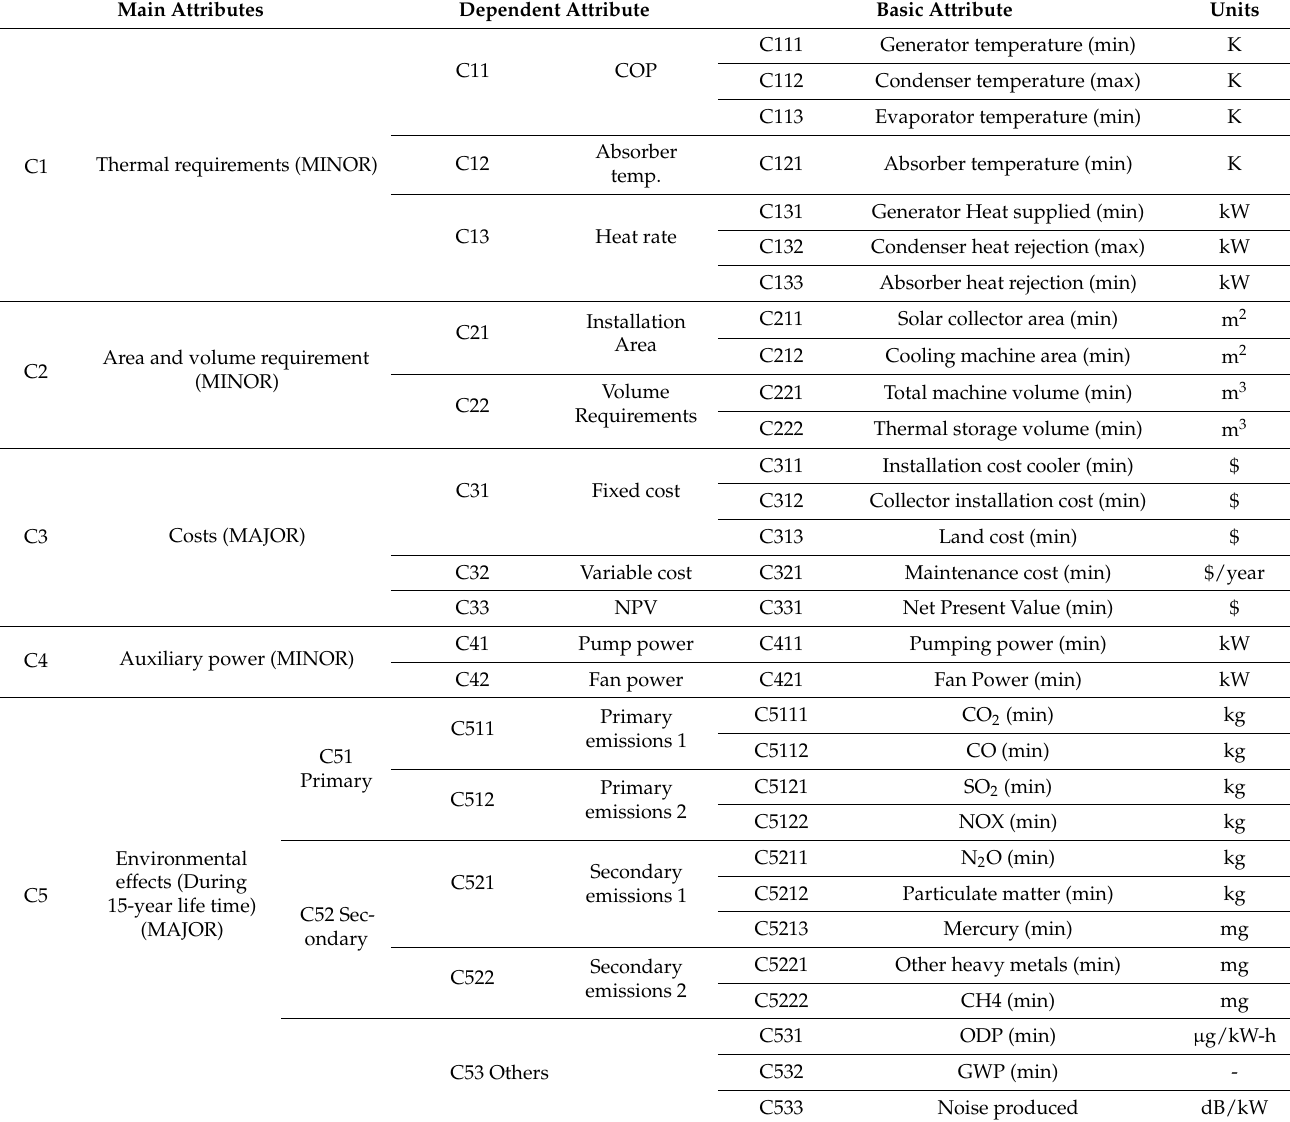
Table 1. The distribution of the different levels of